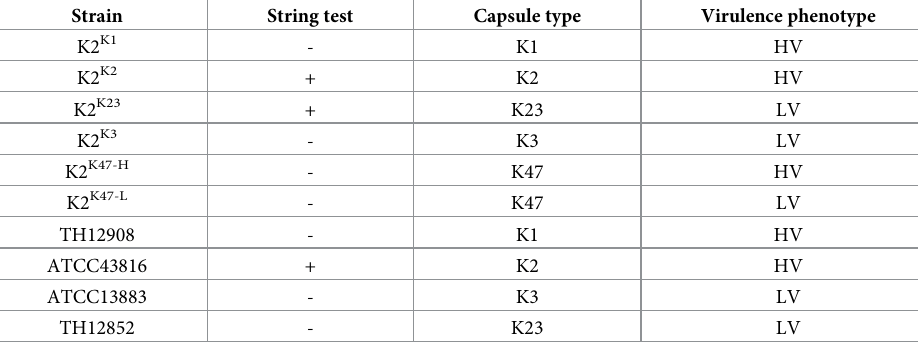
Table 1. Characteristics of isogenic ATCC43816